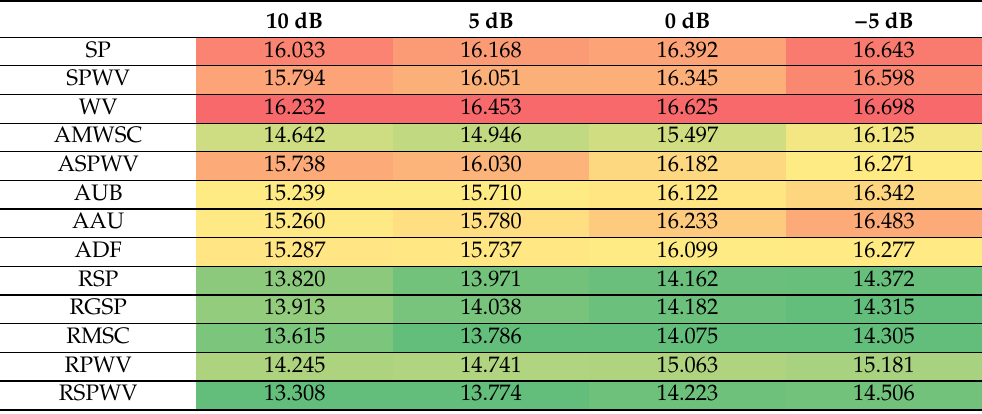
Table 8. TFR Rényi entropy for a noisy multi-component signal with concurrent linear and parabolic FM components for different SNR levels (averaged over 100 noise realizations), cell colors range from green for the best result to red for the worst result in each column respectively. 10